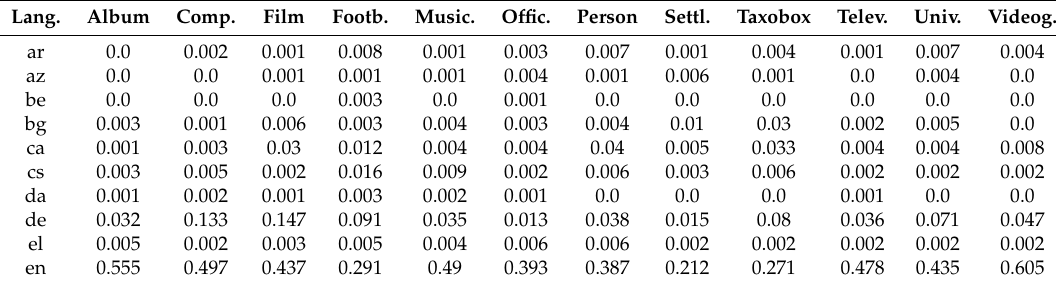
Table A1. Shares of Wikipedia articles with the highest quality score compared with other language versions (articles with at least three language versions were considered). Source: own calculations.